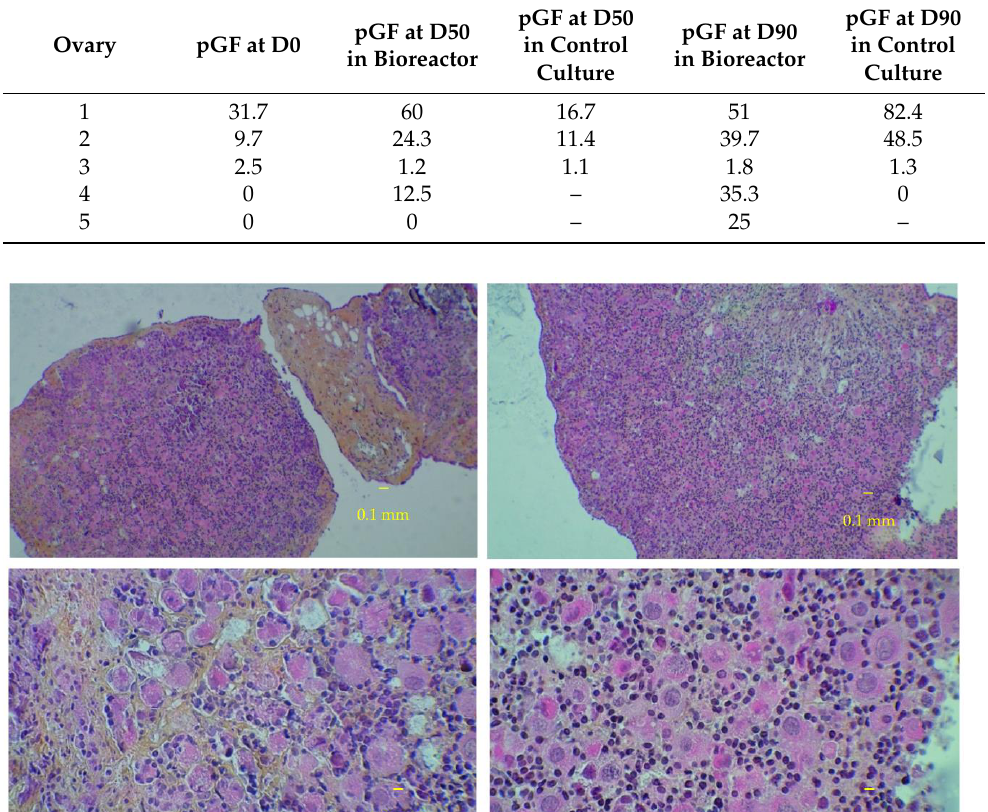
Table 1. Percentages of growing follicles (pGF) relative to all intact follicles according to the culture time and type.